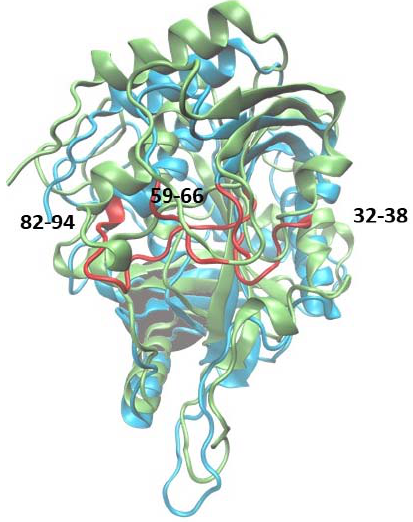
Figure 9. Superposition of the WT3 PNP (one subunit) and 6Ala3 PNP structures observed after 150 ns of MD simulations. The structure of the 6Ala3 PNP is in blue, and WT3 PNP is in green. The regions 32–38, 59–66, and 82–94, which show the largest displacements in the 6Ala3 PNP, as com ‐ pared to WT3 PNP, are shown in